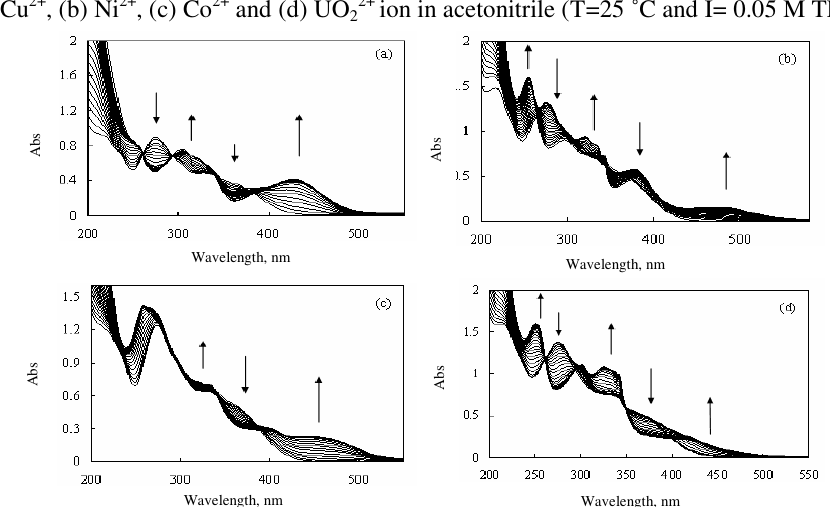
Figure 4. UV-Vis spectra for titration of BSCPHEN (3.8 × 10 -5 M) with metal ions containing (1.0 × 10 -3 ) (a) Cu 2+ , (b) Ni 2+ , (c) Co 2+ and (d) UO 22+ in acetonitrile (T=25 ˚C and I= 0.05 M